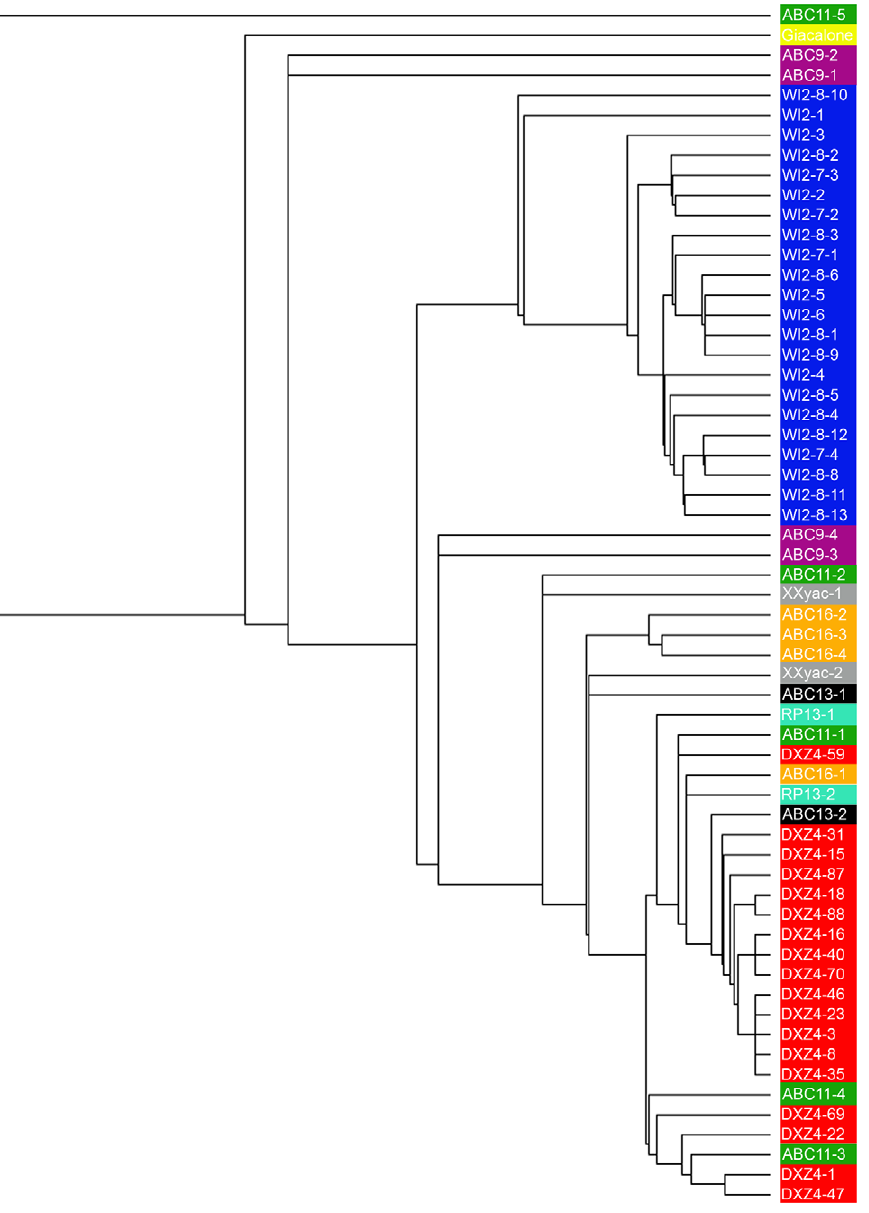
Figure 3. Relationship of DXZ4 monomer sequence within and between individuals. Cladogram of 60 complete DXZ4 monomer DNA sequences. Tree image generated using MUSCLE version 3.8 [37]. Color highlights added in Adobe Photoshop CS (Ver.8.0). Sequences labeled DXZ4-1 through 88 and highlighted in red represent sequences derived from BAC clone 2272M5 (this manuscript). Sequences labeled WI2 and highlighted in blue represent sequences taken from clones from the WIBR-2 human fosmid library. Sequence accession numbers include WI2-7 AC196704.1, WI2 AC193162 and WI2-8 CR753863.9. Sequences labeled ABC and colored green, mauve, orange and black are derived from fosmid libraries from four individuals of different ethnicities [23]. Sequence accession numbers include: ABC9 AC212298.1, ABC11 AC236928.2, ABC13 AC226798 and ABC16 AC238719.3. The sequence highlighted in yellow annotated Giacalone is taken from accession number S60754 [5]. Sequences labeled XXyac highlighted in grey are derived from XXyac-74A3 (BX546444.14). RP13 sequences derived from accession number